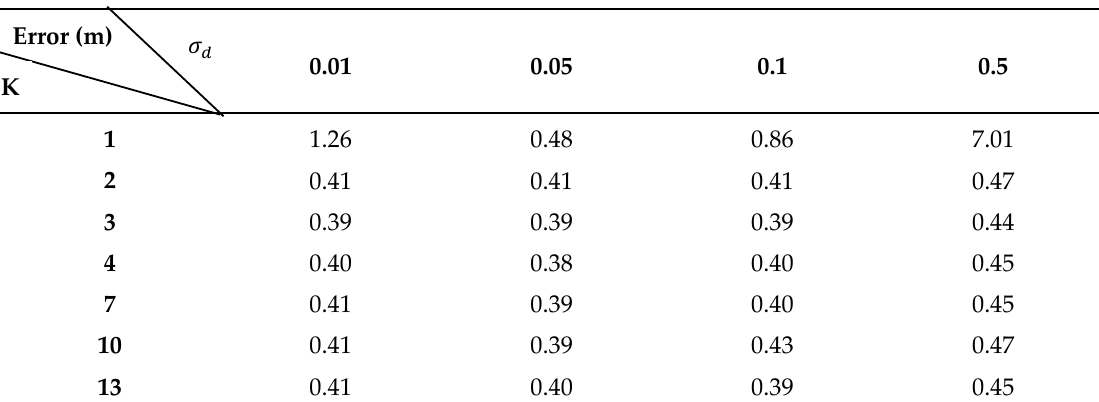
Table 6. E ff ect of K and σ d on localization accuracy. Table 6. Effect of K and 𝜎 (cid:3031) on localization